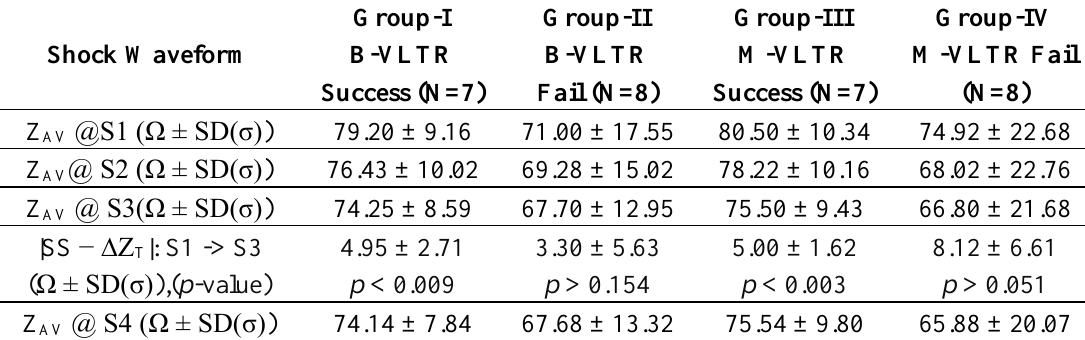
Table 3. Dynamic changes in ICI(Z AV ) between shocks measured for the B-VLTR and